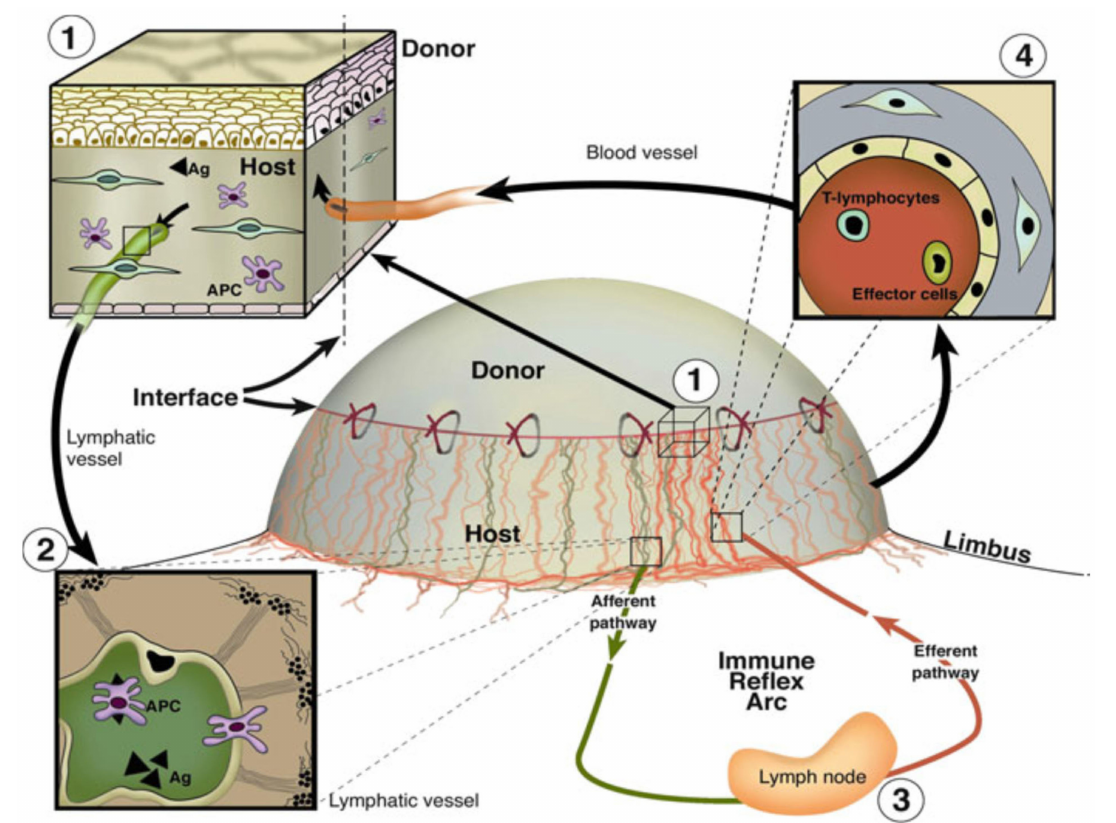
Figure 1. Importance of blood and lymphatic vessels in the host bed of high-risk corneas as exit and entry routes of the immune reflex arc for subsequent immunologic graft rejection. ( 1 ) Magnification of the host–graft interface: blood (red) and lymphatic vessels (green) reach the host–graft interface. Antigen (Ag) and antigen presenting cells (APCs) both of host and donor can leave the cornea using corneal lymphatics ( 2 ), conjunctival lymphatics and then as the afferent arc of the immune response reach the regional lymph nodes ( 3 ). After stimulation of alloreactive T lymphocytes, these and other effector cells/antibodies can reach the graft via corneal blood vessels (( 4 ): efferent arc of the immune response). Reproduced from Cursiefen et al. 2003